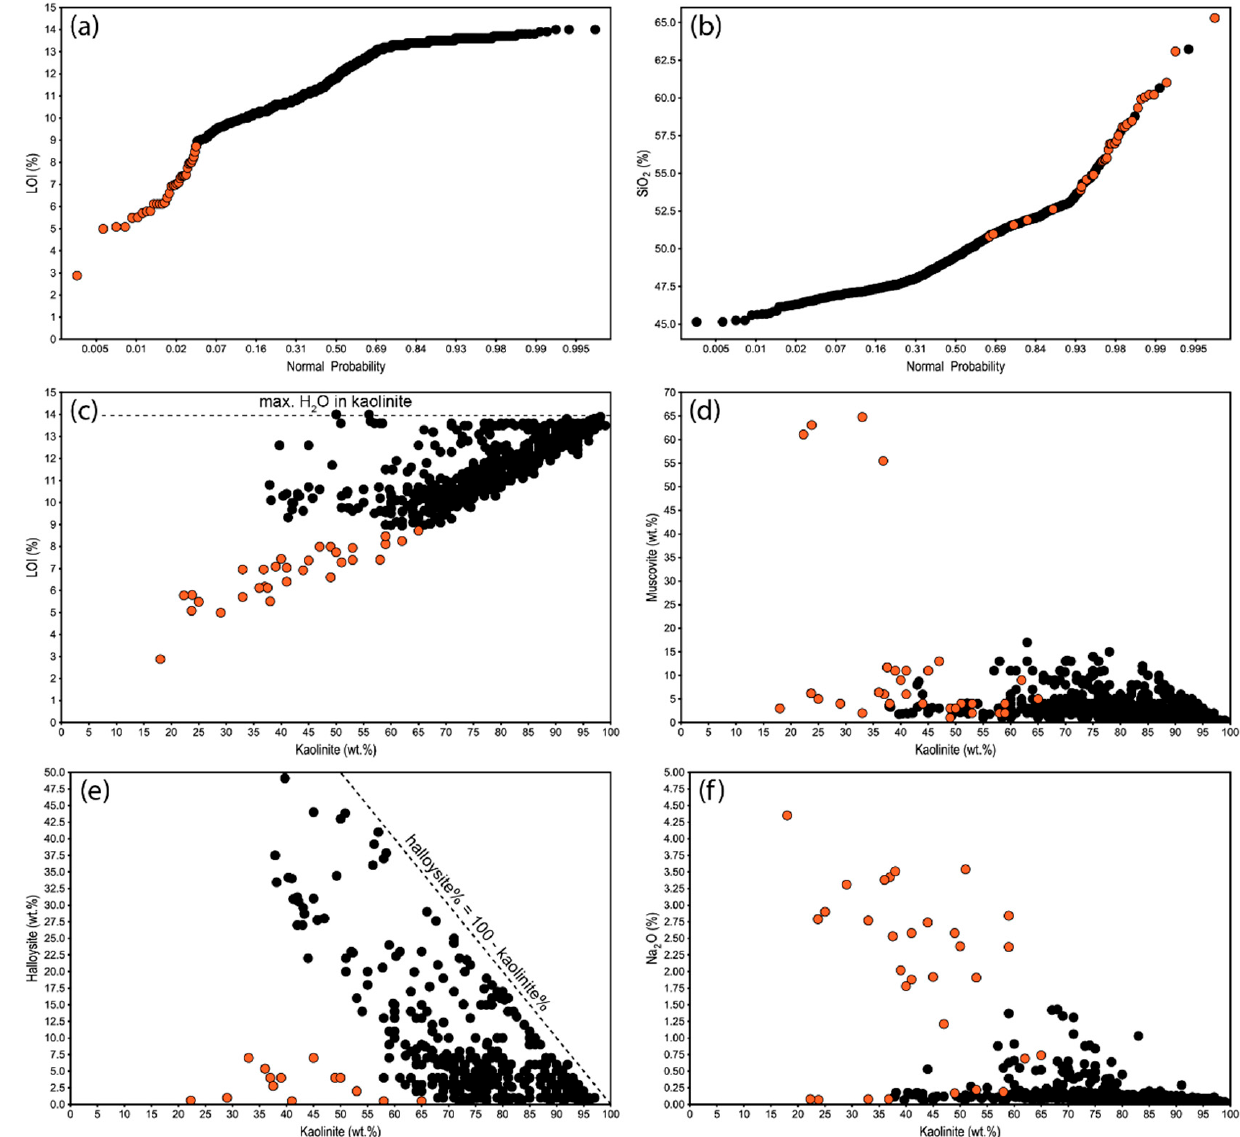
Figure 5. ( a ) Normal probability plot for LOI (<8.75% coloured orange in this and following panels); ( b ) normal probability plot for SiO 2 ; ( c ) kaolinite (wt.%) vs. LOI (wt.%); ( d ) kaolinite (wt.%) vs. muscovite (wt.%); ( e ) kaolinite (wt.%) vs. halloysite (wt.%); ( f ) kaolinite (wt.%) vs. Na 2 O (wt.%).